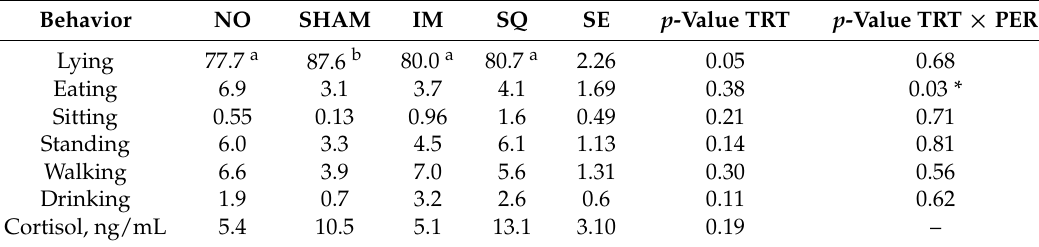
Table 2. Least squares means for percent of time finishing pigs spent exhibiting behaviors for combined before and after treatment periods and cortisol concentrations for 1 h after treatment period. Periods (PER) were divided into 1 h before treatment and 1 h after treatment. Treatments (TRT): touch to neck (SHAM), intramuscular (IM) injection, subcutaneous (SQ) injection, or nothing (NO). N = 40 pig observations.